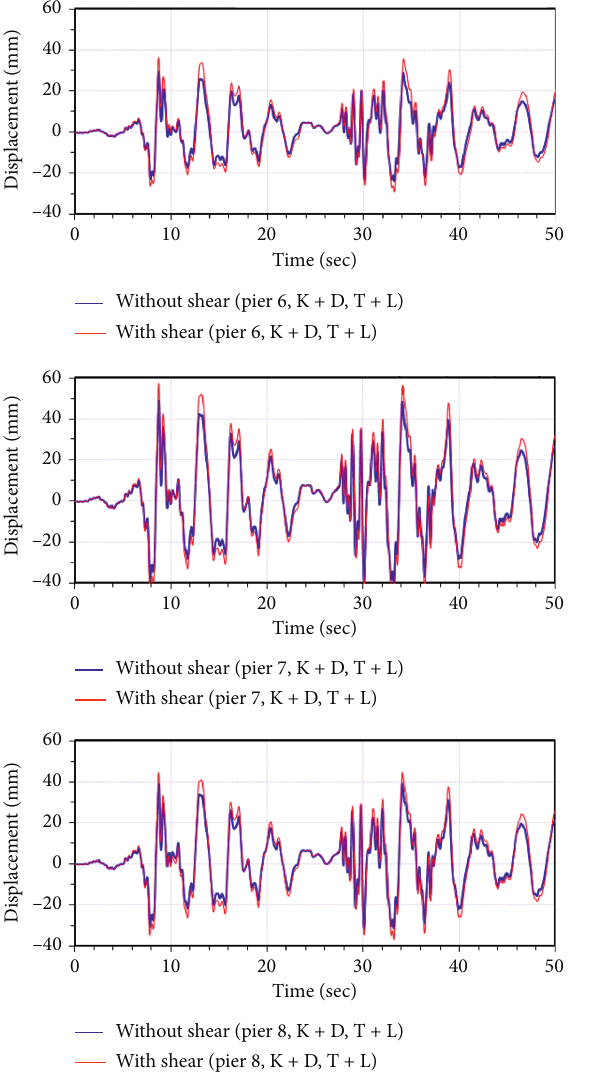
Figure 11: Transverse displacement response without and with shear subjected to biaxial input ground motions of multiple earthquakes, K+D.